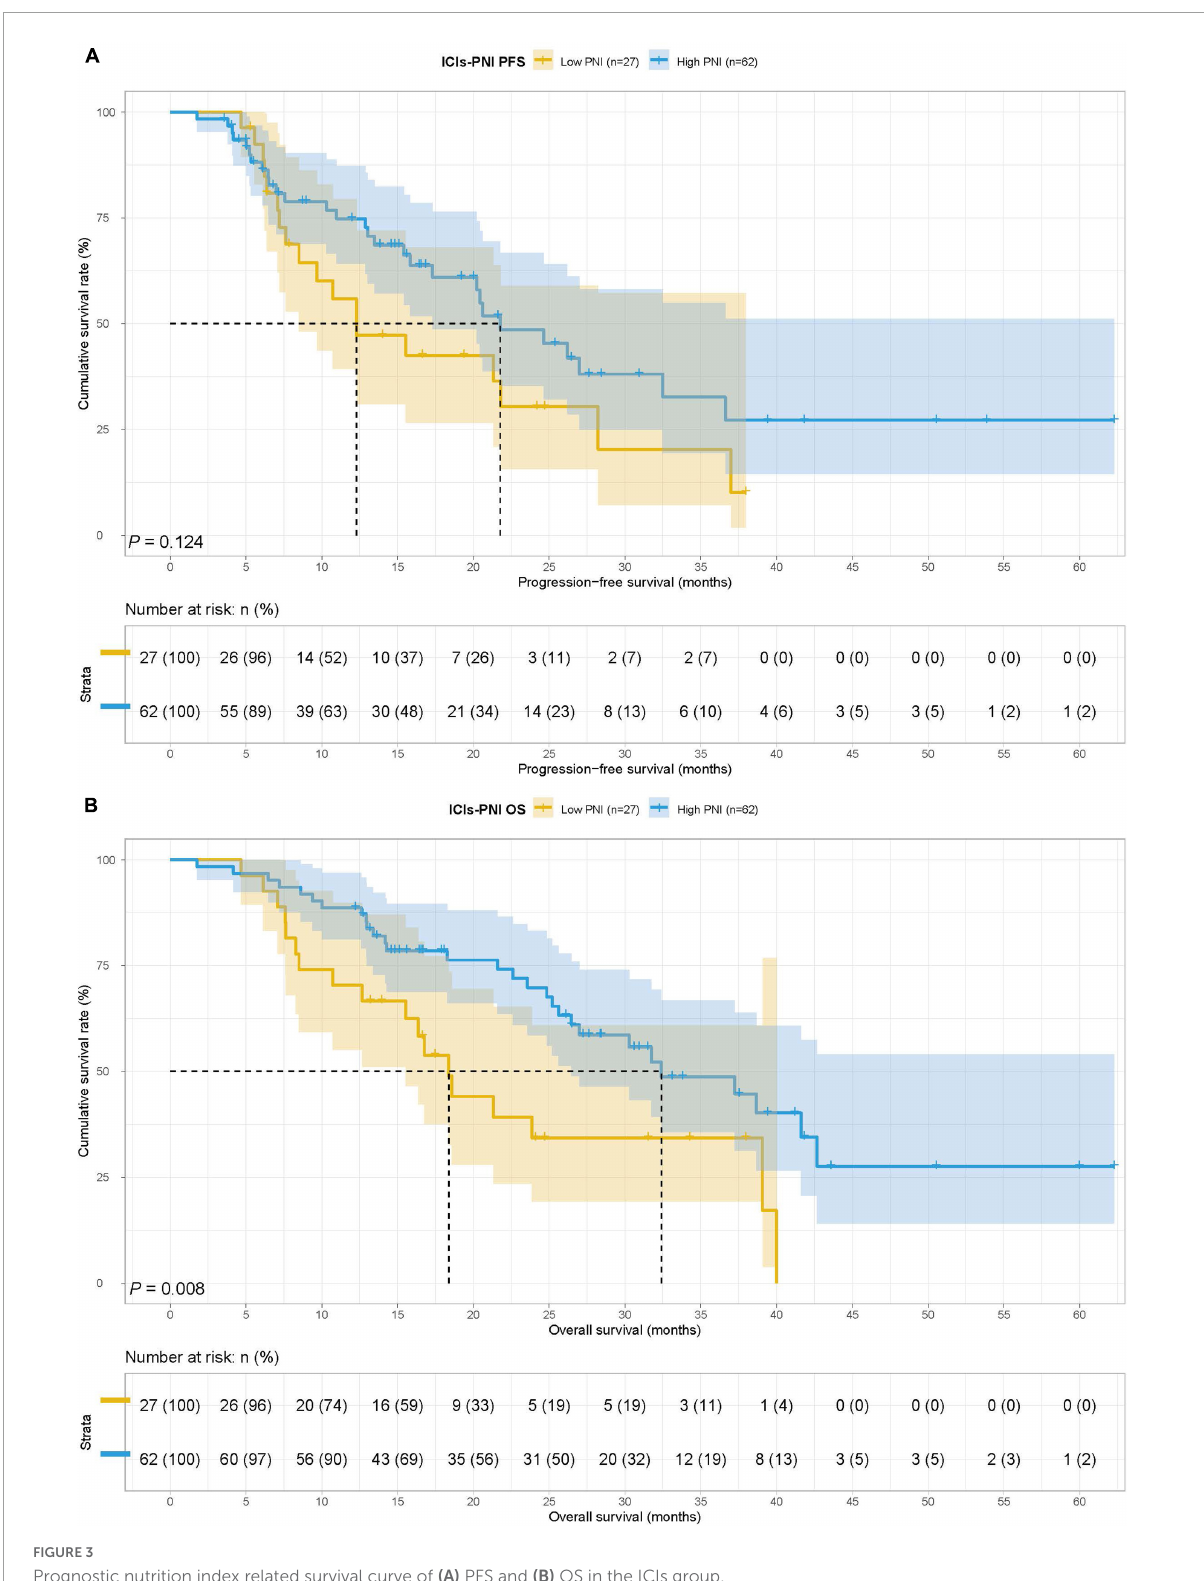
FIGURE3 Prognostic nutrition index related survival curve of (A) PFS and (B) OS in the ICIs group.